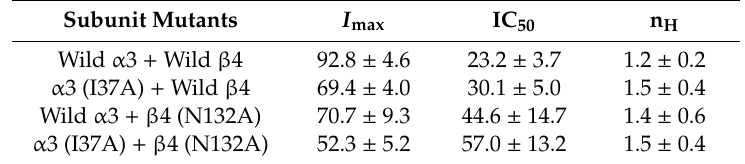
Values represent means ± SEM ( n = 6 − 7 / group). Currents elicited at holding potential of − 80 mV. IC 50 ( µ M), Hill’s coe ffi cient, and I max (%)determined as described in Materials and